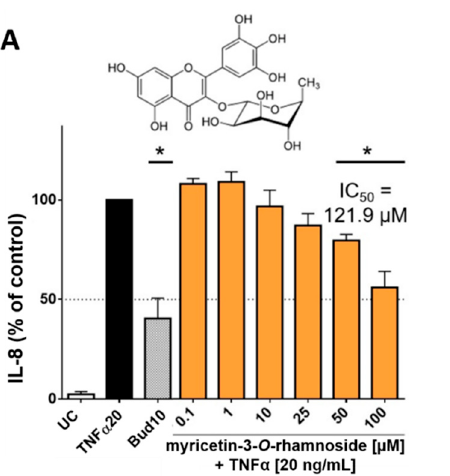
Figure 5. Influence of myricetin-3- O -rhamnoside and myricetin on IL-8 released by HaCaT cells after stimulation with TNF α (20 ng / mL): The main phenolic compound of CCL, myricetin-3- O -rhamnoside ( A ) and its aglycone myricetin ( B ) concentration-dependently reduced the levels of IL-8 at nontoxic concentrations. The compounds were tested in concentrations ranging from 0.1–100 µ M, resulting in IC 50 values for IL-8 of 121.9 µ M for myricetin-3- O -rhamnoside ( A ) and 90.69 µ M for myricetin ( B ), respectively. 10 µ M budesonide (Bud 10) was used as a positive control, UC = Untreated control, n = 4–6 replicates, data presented as mean ± SEM, significant for * p ≤ 0.05 compared to TNF α control in ordinary one-way ANOVA.